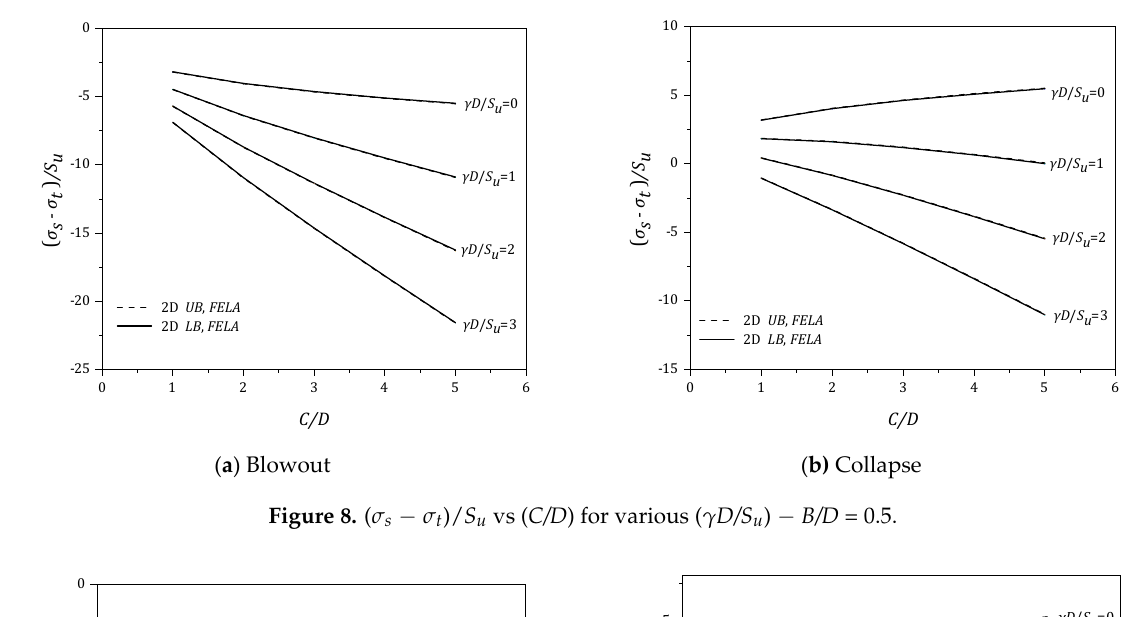
Figure 8. ( σ s − σ t )/ S u vs ( C/D ) for various ( γ D/S u ) − B/D = 0.5.